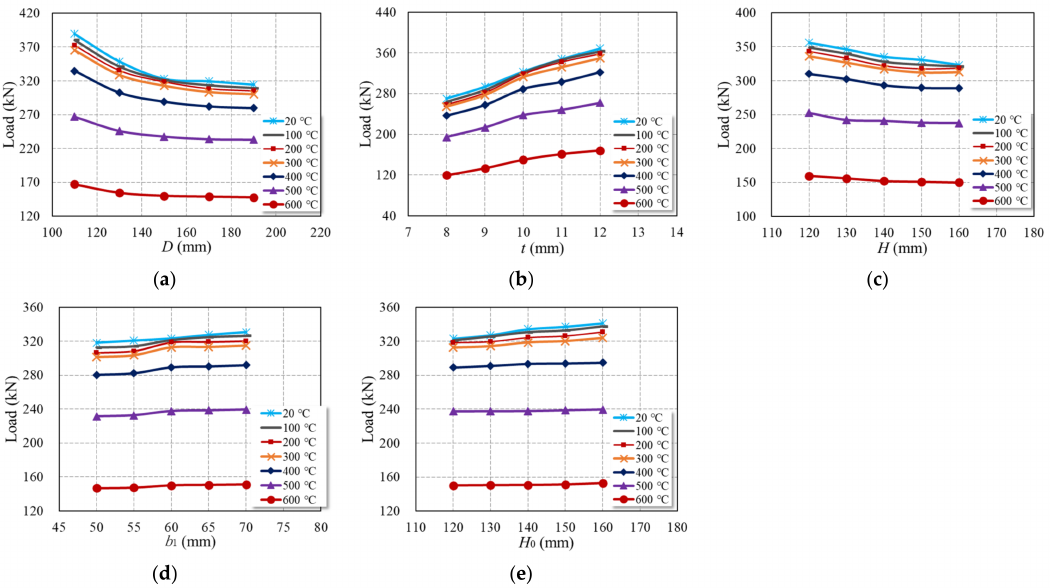
Figure 13. Effects of parameters on the load-carrying capacity of BBC joints under tension: ( a ) outer diameter of the tube; ( b ) thickness of the tube; ( c ) height of the tube; ( d ) width of the tubular beam; ( e ) height of the tubular beam.